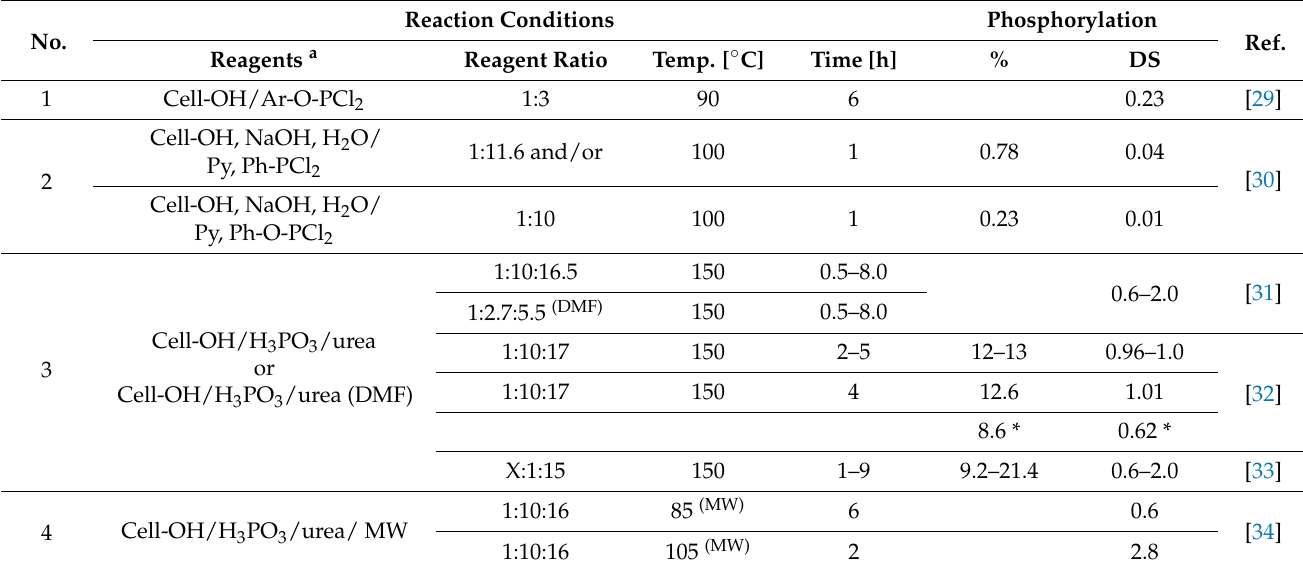
Table 1. Characteristics of phosphorylation procedures afforded cellulose- O -phosphates